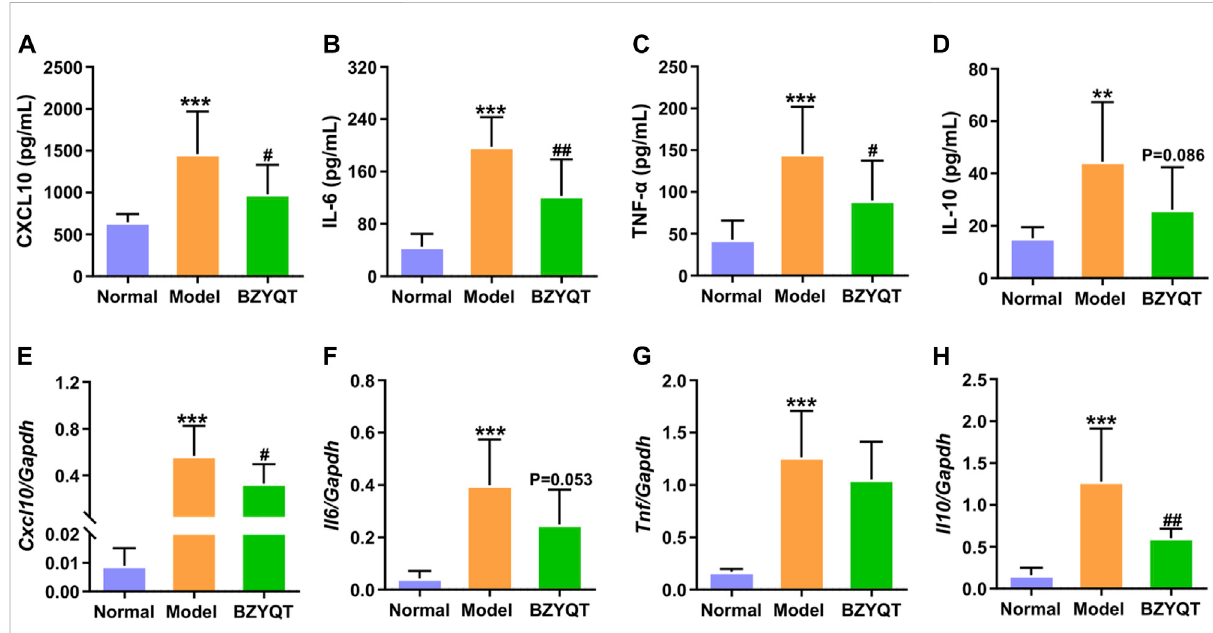
FIGURE 3 Anti-in fl ammatoryeffectsofBZYQTonthepulmonaryin fl ammationinducedbypoly(I:C).BZYQTwasprotectivelyadministeredfor3 days( n = 7 or 8). Contents of (A) CXCL10, (B) IL-6, (C) TNF- α , and (D) IL-10 in the BALF; mRNA expression of (E) Cxcl10 , (F) Il6 , (G) Tnf , and (H) Il10 in the lung. Data were shown as mean ± SD, and analyzed by one-way ANOVA; differences identi fi ed using Dunnett ’ s multiple comparisons test: ** p <